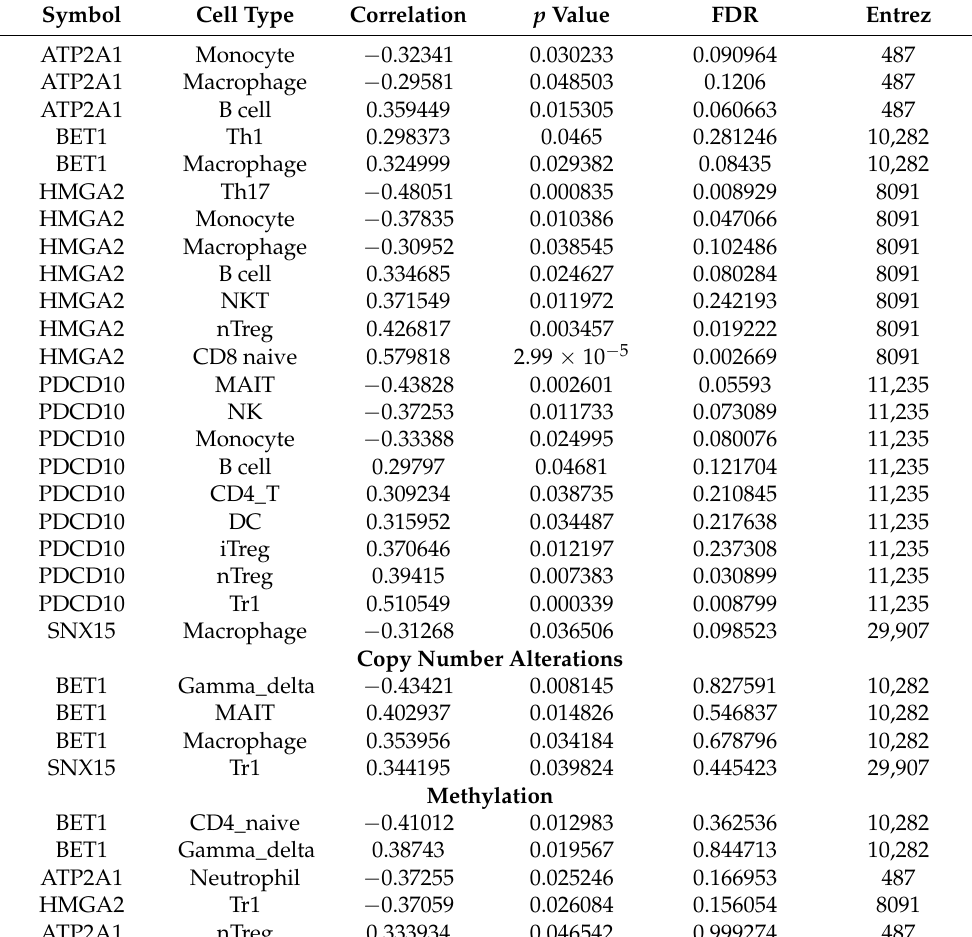
Table 2. Correlation of cholangiocarcinoma (CHOL)-hub gene mRNA expression levels and infiltra- tion by tumor immune